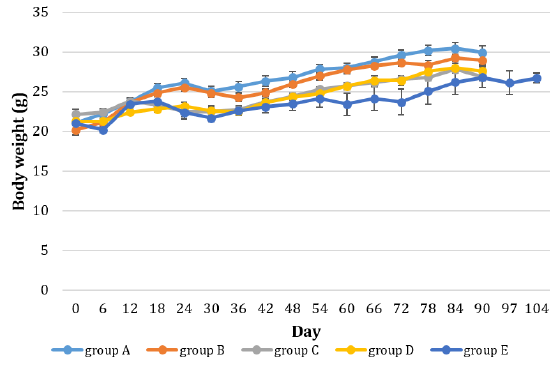
Figure 2. Mean body weight change in mice treated with 14 (group B), 28 (group C), 56 mg/kg/d DPP (group D), and recovery group (group E) as compared to the control group (group A) during sub-chronic toxicity study (P>0.05) (Utami, 2017).